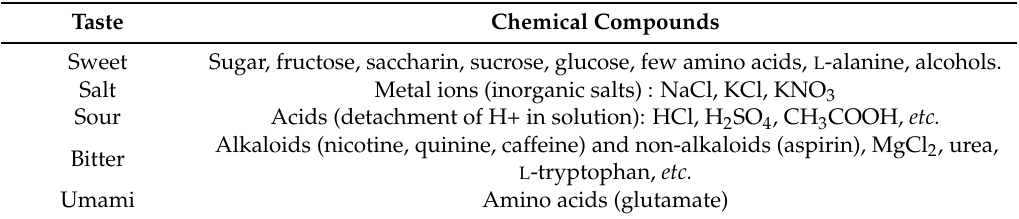
Table 2. Three levels of analogy between human and electronic tongue taste recognition mechanisms.